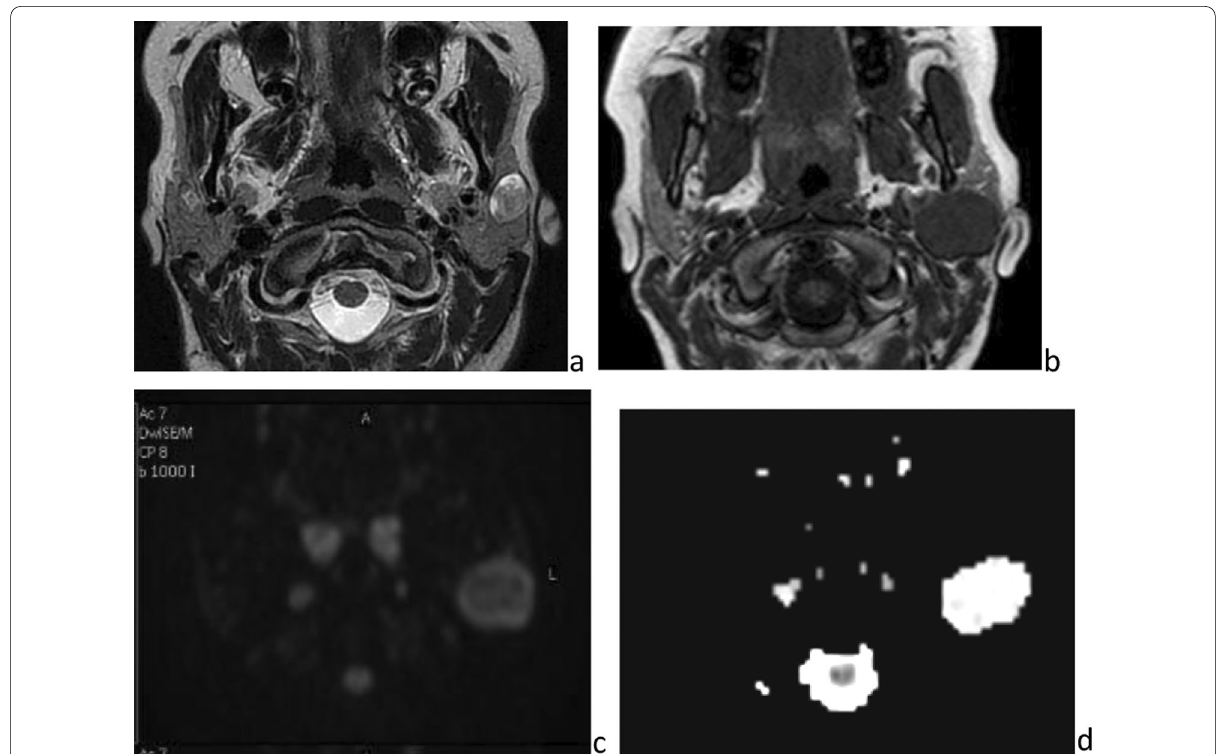
Fig. 14 Pleomorphic adenoma or mixed tumor. Axial T 2 ‑weighted image showing the hypointense capsule well delineating the tumor ( a ). At a different slice level, axial T